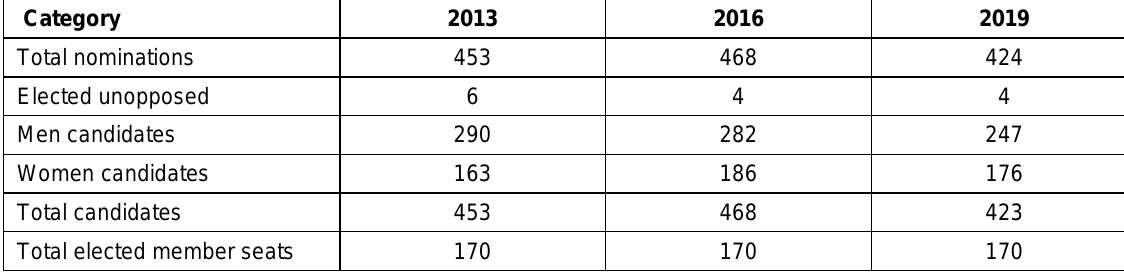
Table 2: Number of Auckland Council candidates comprising the research cohort Category